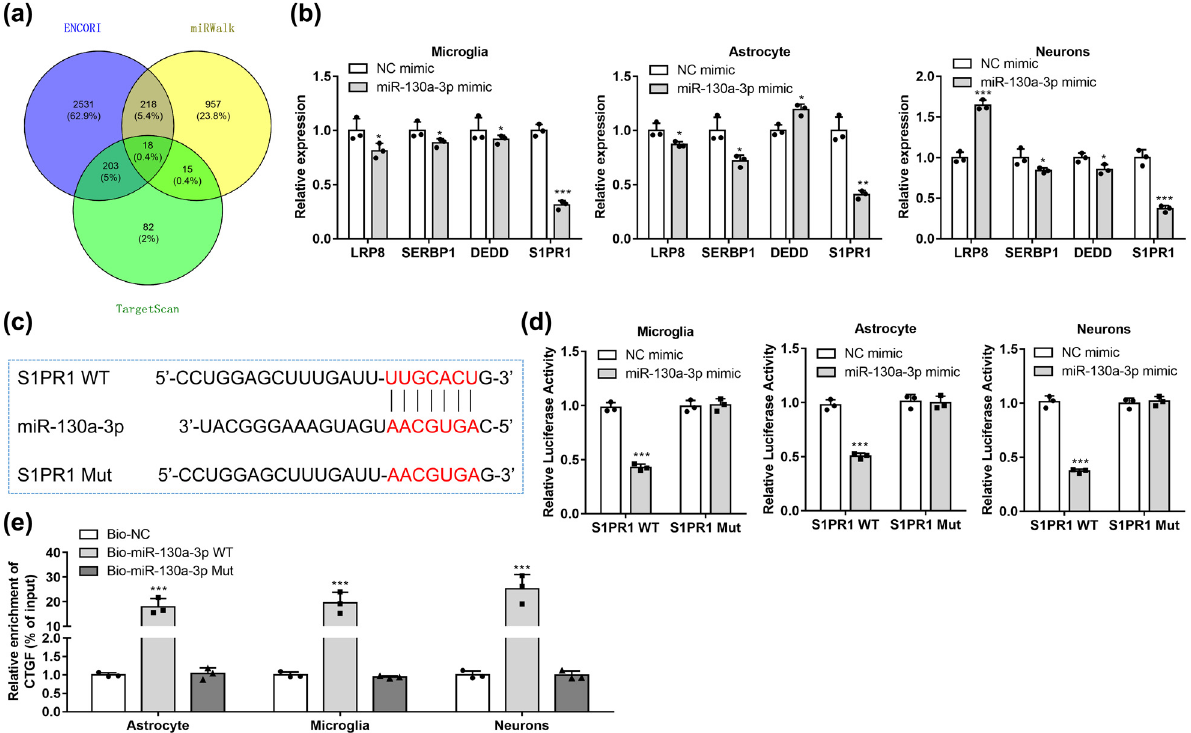
Figure 5: S1PR1 is a target of miR - 130a - 3p. ( a ) The Venn diagram shows 18 targeted mRNAs of miR - 130a - 3p that are predicted by ENCORI, TargetScan, and miRWalk databases. ( b ) Expression of LRP8, SIPR1, SERBP1, and DEDD was determined by RT - qPCR in microglia, astrocytes, and neurons transfected with miR - 130a - 3p mimics. ( c ) Binding sequences between miR - 130a - 3p and SIPR1 3 ′ - UTR were obtained from TargetScan. ( d ) A dual luciferase reporter assay for con fi rmation of the interaction between miR - 130a - 3p and SIPR1 3 ′ - UTR in microglia, astrocytes, and neurons. ( e ) RNA pull - down assay was used to verify the relationship between S1PR1 and miR - 130a - 3p. * P < 0.05, ** P < 0.01, *** P < 0.001 vs NC mimic